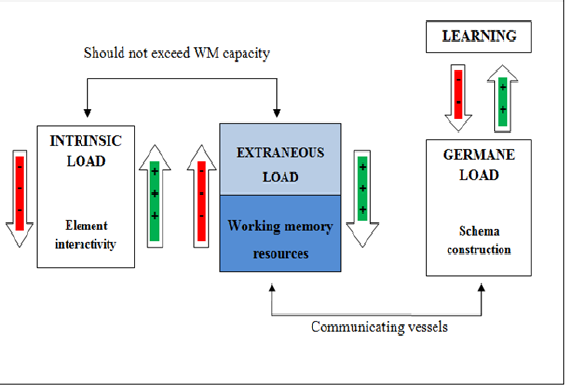
Figure 1. The influence of cognitive load on problem solving performance Note: Green arrows (with positive signs) represent cognitive processes that support learning and enhancement of problem solving performance, and red arrows (with negative signs) represent cognitive processes that defeat learning and do not enhance problem solving performance. Source: Dhlamini (2012, p.